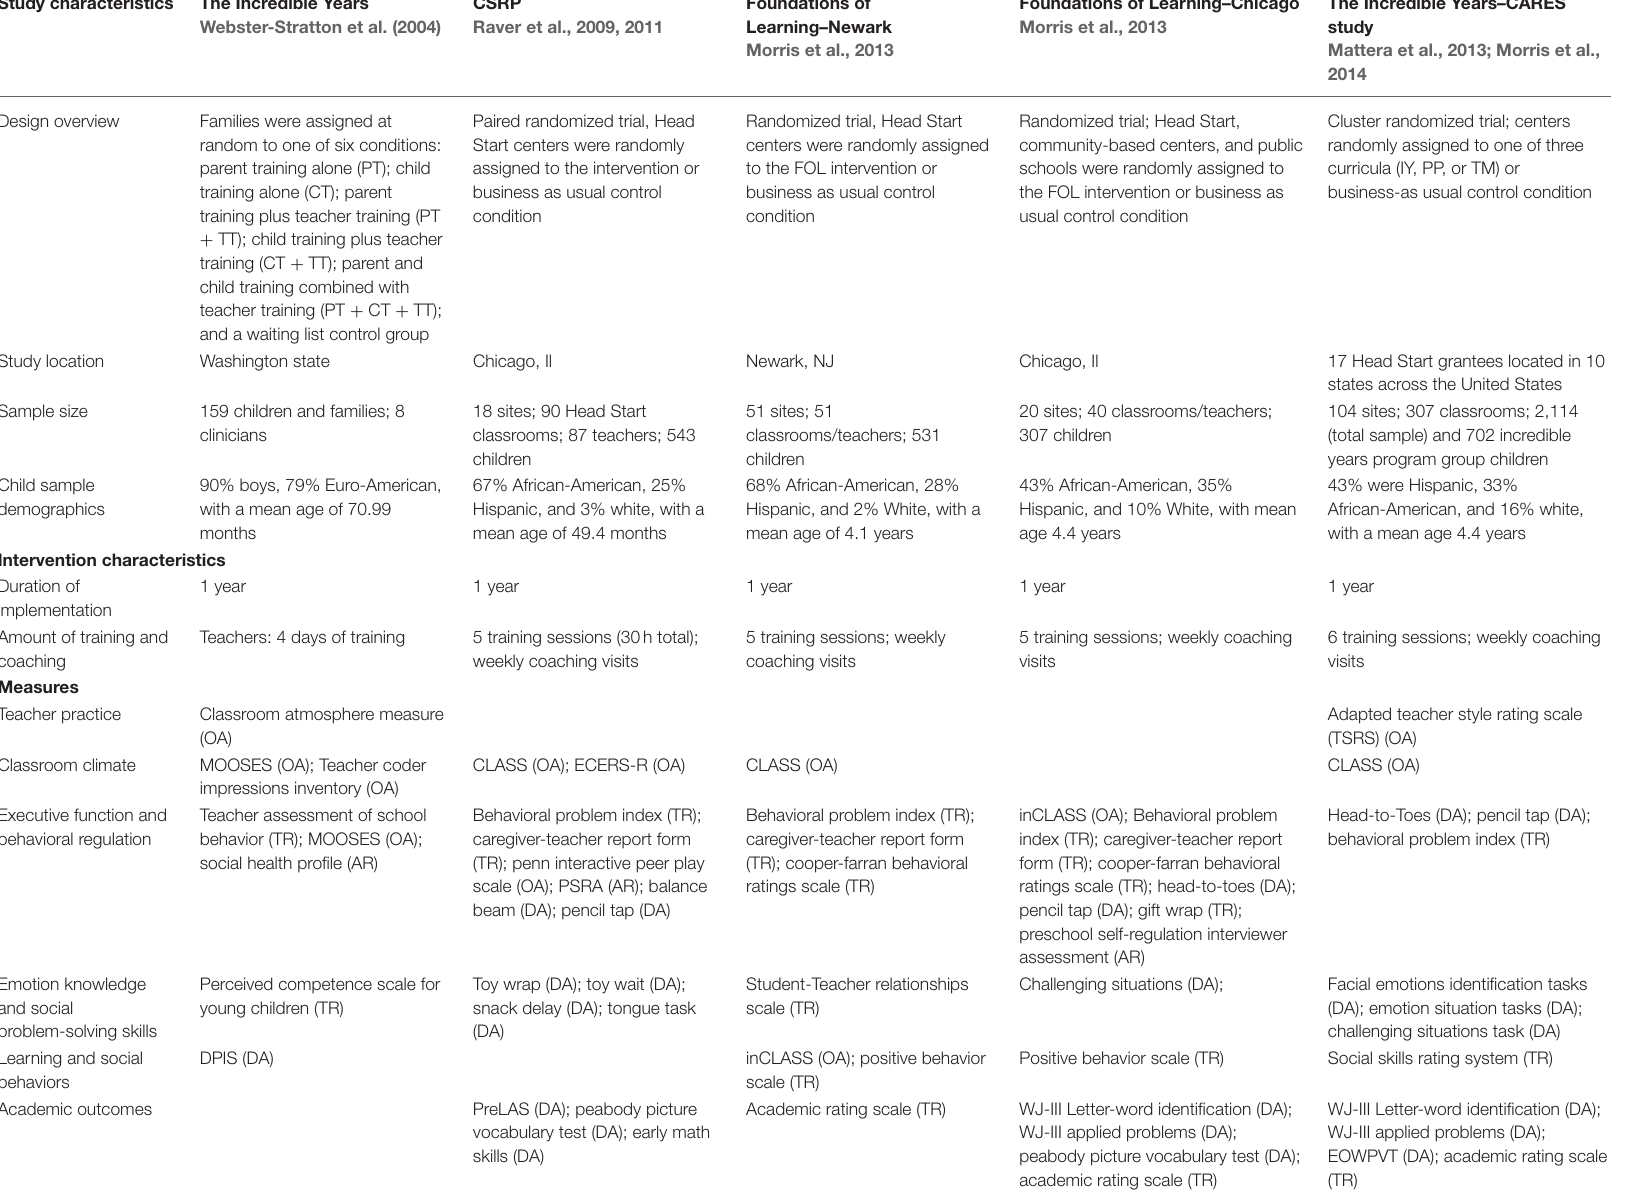
TABLE 1 | Background characteristics of the behavioral-focused